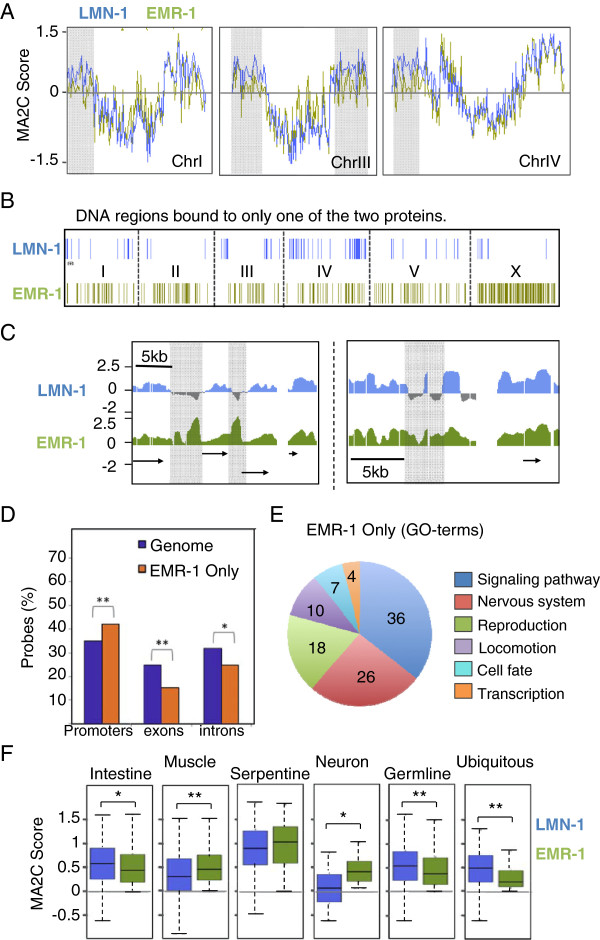
EMR-1 associates with muscle and neuronal genes. (A) Comparison of the regions enriched for LMN-1 and EMR-1 in chromosomes I, III and IV (100-kb window MA2C score). Grey boxes mark regions where LMN-1 associates more strongly than EMR-1. (B) Position of ‘LMN-1 only’ and ‘EMR-1 only’ elements as defined in Materials and methods. (C) Genome browser views of LMN-1 and EMR-1 occupancy in regions containing ‘EMR-1 only’ elements (grey boxes) at promoters (left panel) and in intergenic regions (right panel). (D) Distribution of ‘EMR-1 only’ probes in promoters, introns and exons relative to the genome. Probability values from one-sided binomial tests are indicated as in (B). (E) Gene Ontology (GO) analysis of genes included in ‘EMR only’ elements. GO terms with P < 0.05 were considered significant. Numbers in the pie chart indicate the number of genes in each category. (F) LMN-1 and EMR-1 occupancy for various gene sets defined by expression data. Number of genes: intestine (555), muscle (359), serpentine (325), neuron (14), germ line (618) and ubiquitous (174). Serpentine genes encode chemoreceptors expressed in a few neurons only. Boxplots (as in Figure 1) show the range of MA2C scores averaged over gene bodies. Probability values from Wilcoxon rank sum tests are indicated: *P < 0.05, **P < 10-4.